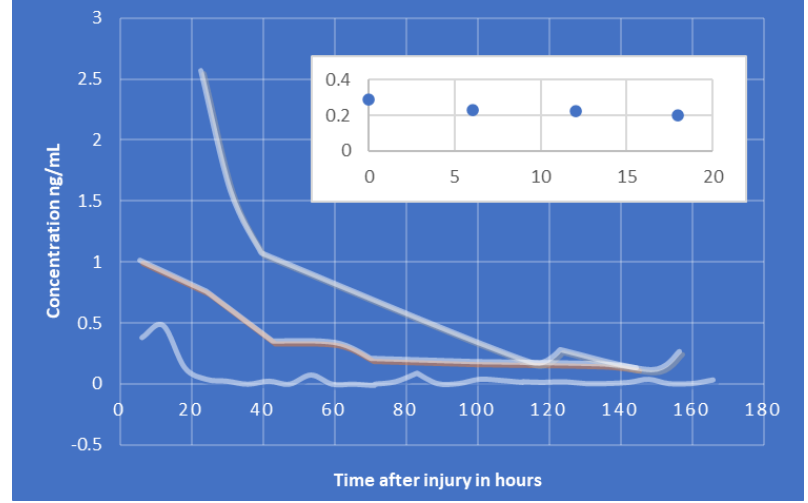
Figure 42. Kinetics of biomarker UCH-L1 (data from [141 – 143]).